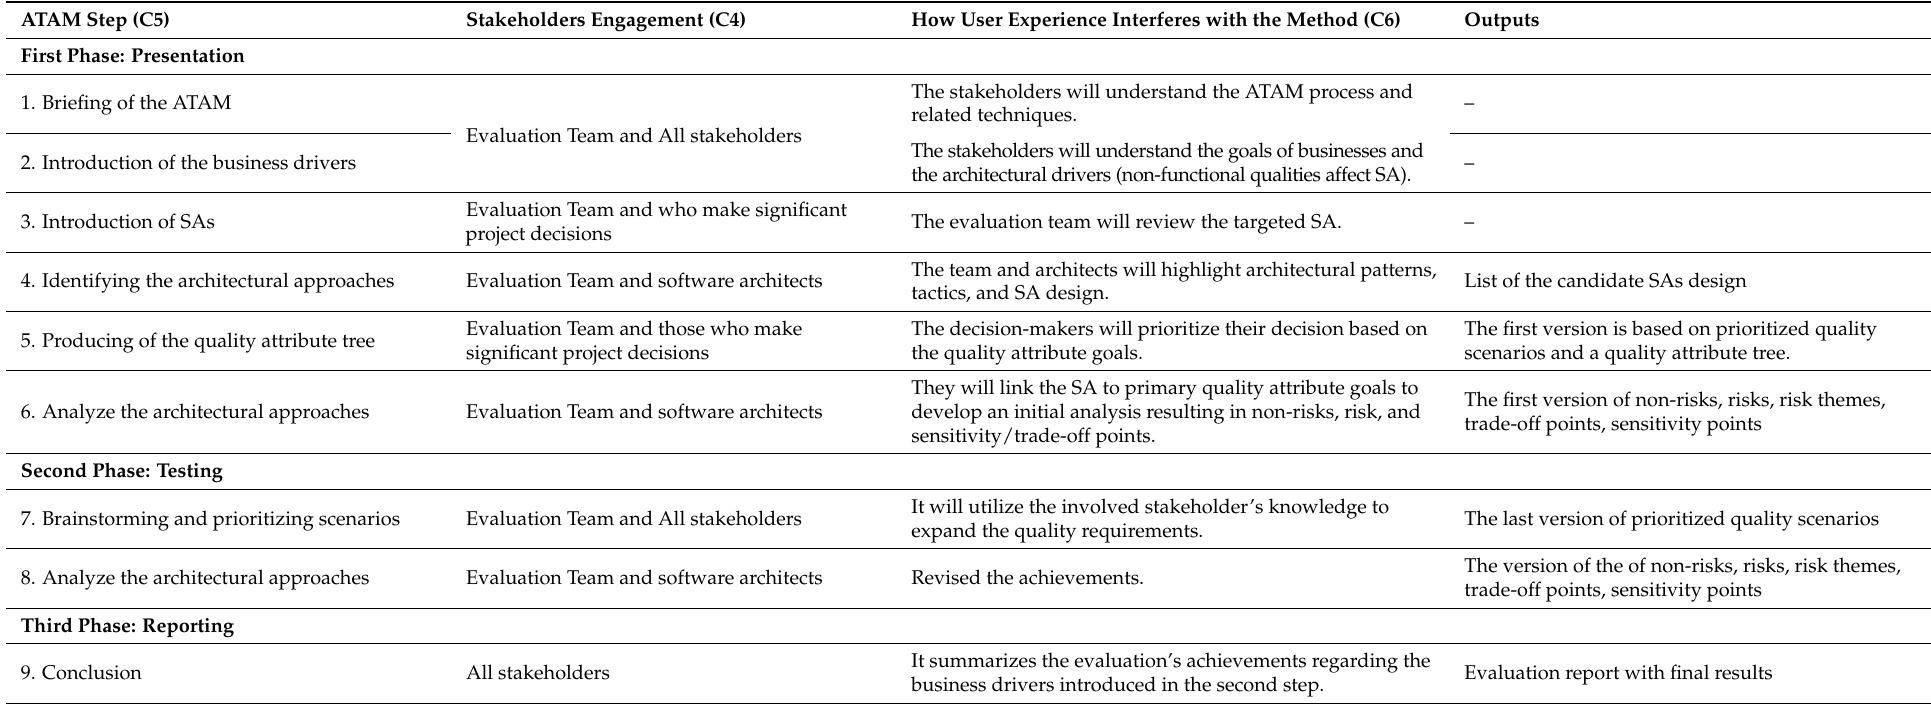
Table 4. The steps of